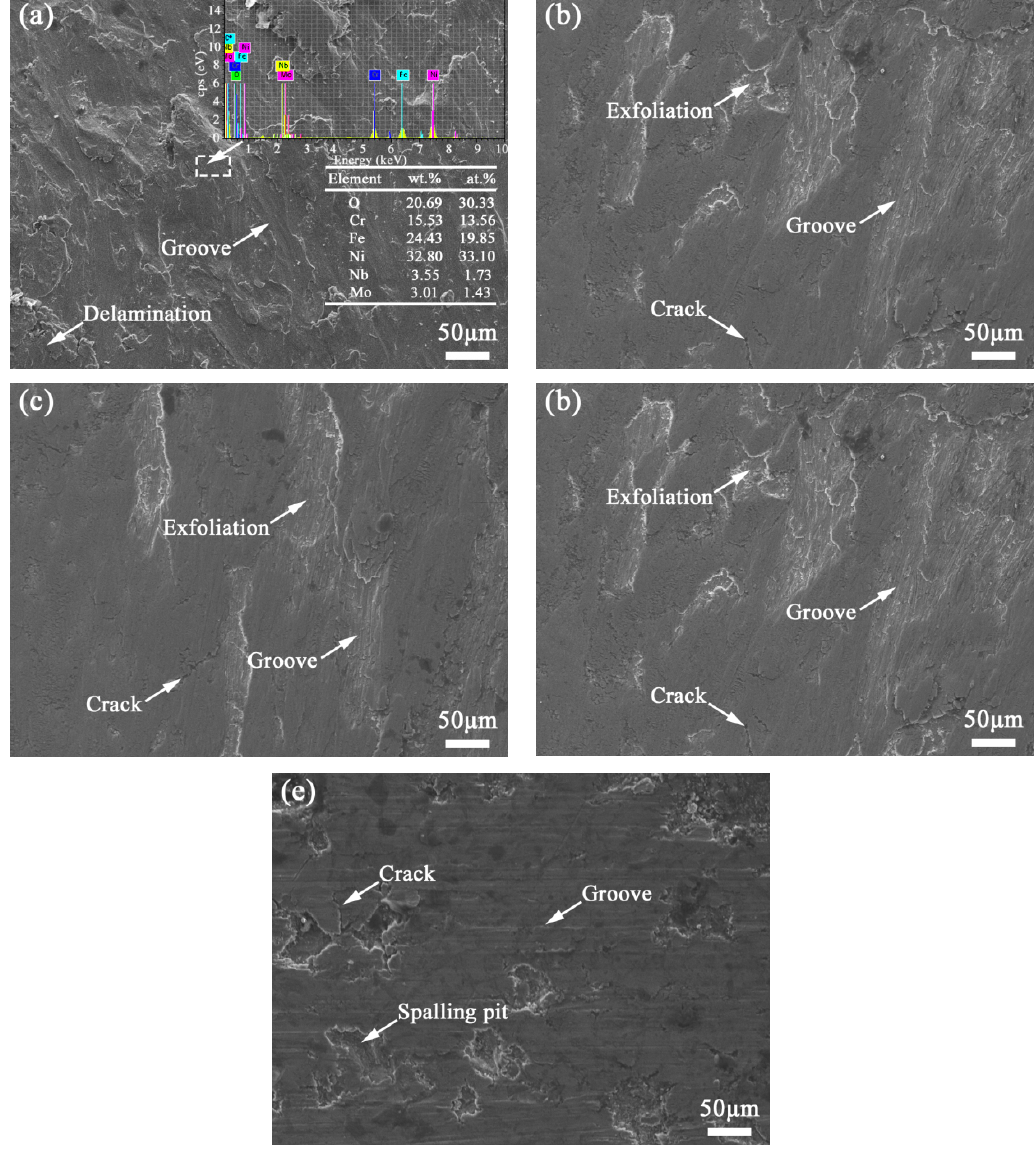
Figure 14. SEM images of the worn surface of coatings ( a ) TB0, ( b ) TB10, ( c ) TB20, ( d ) TB30 and ( e ) TB40.